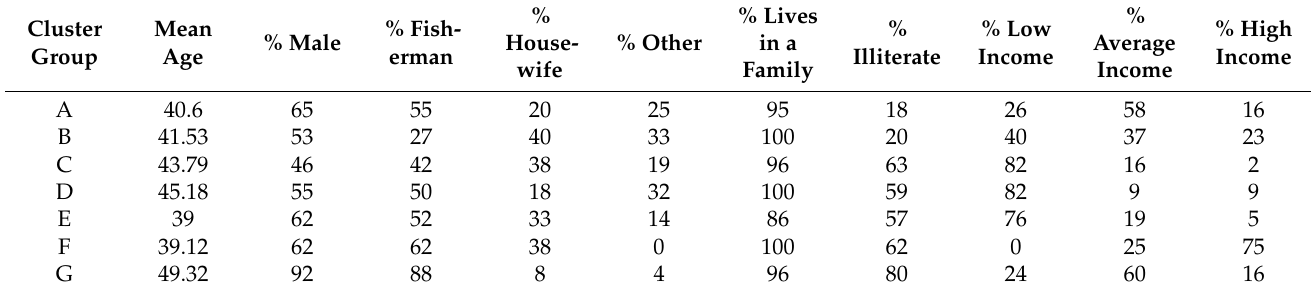
Table 3. Demographic characteristics of clusters.